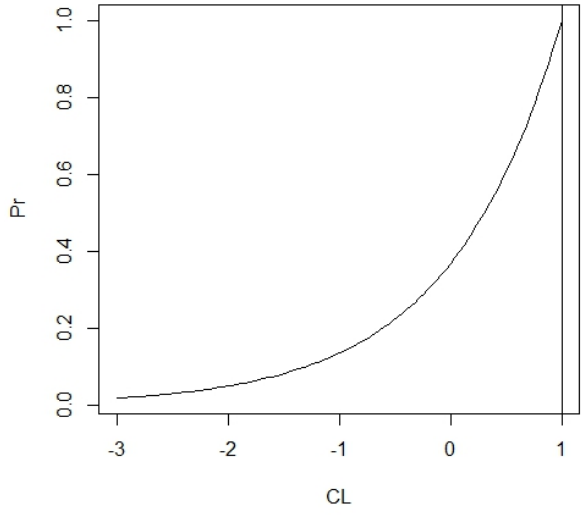
Figure 1. The relationship between P r and C L .